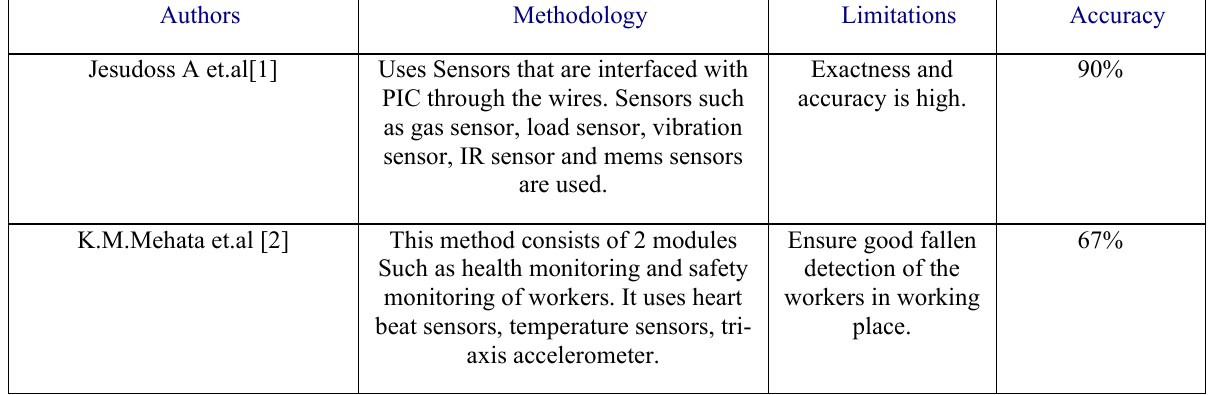
Table 1. Provides the comparison of the survey on Smart helmet using